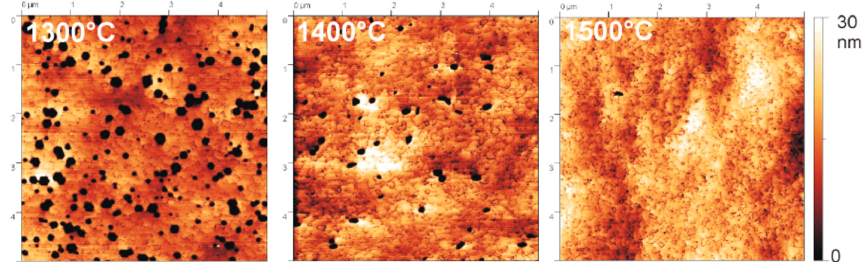
Figure 4. Atomic force microscopy (AFM) scans (5 × 5 μ m) of 0.7 μ m thick AlN: nid on sapphire grown ◦ C, 1400 ◦ C, and 1500 ◦ C. RMS values are 4 nm, 1 nm and 0.4 nm at temperatures of 1300 °C, 1400 °C, and 1500 °C. RMS values are 4 nm, 1 nm and 0.4 nm from left to grown at temperatures of 1300